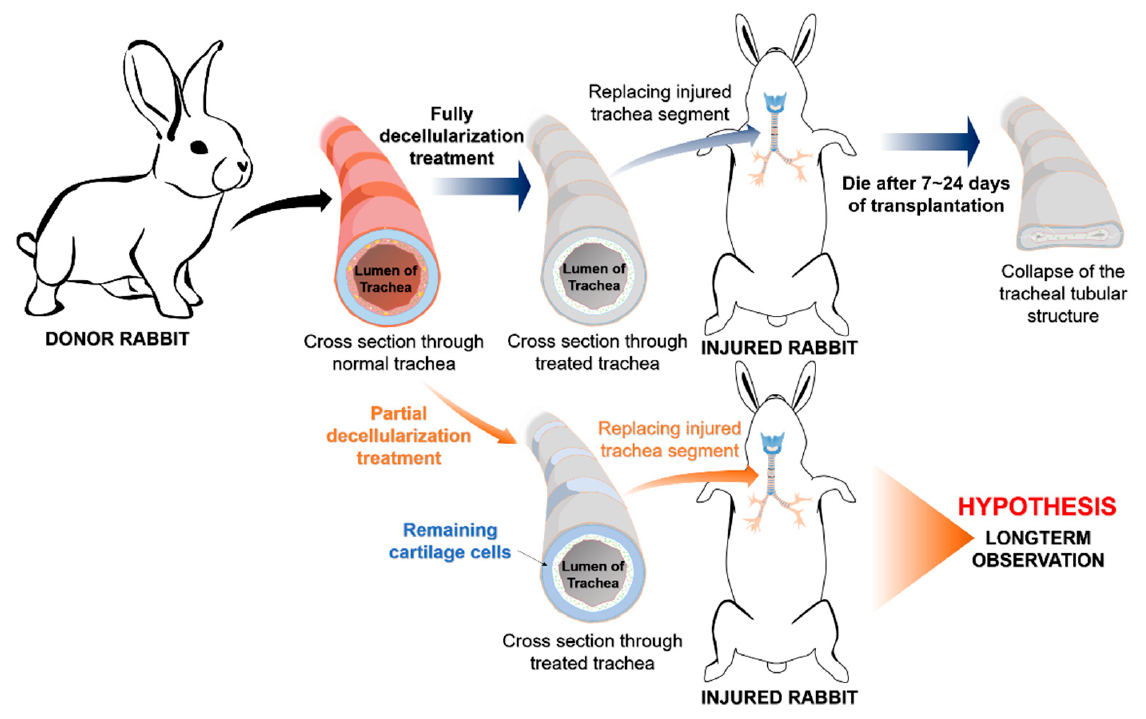
Figure 1. Illustration of the novel concept of the partial decellularization method applied in this study.